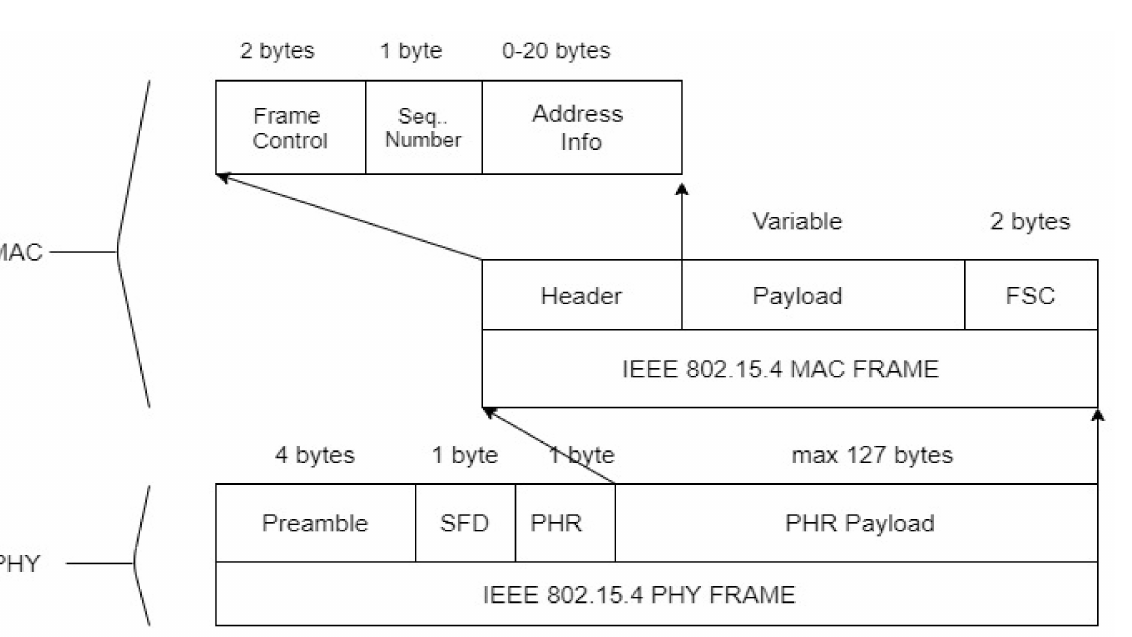
Figure 5. IEEE 802.15.4 frame on 2.4GHz